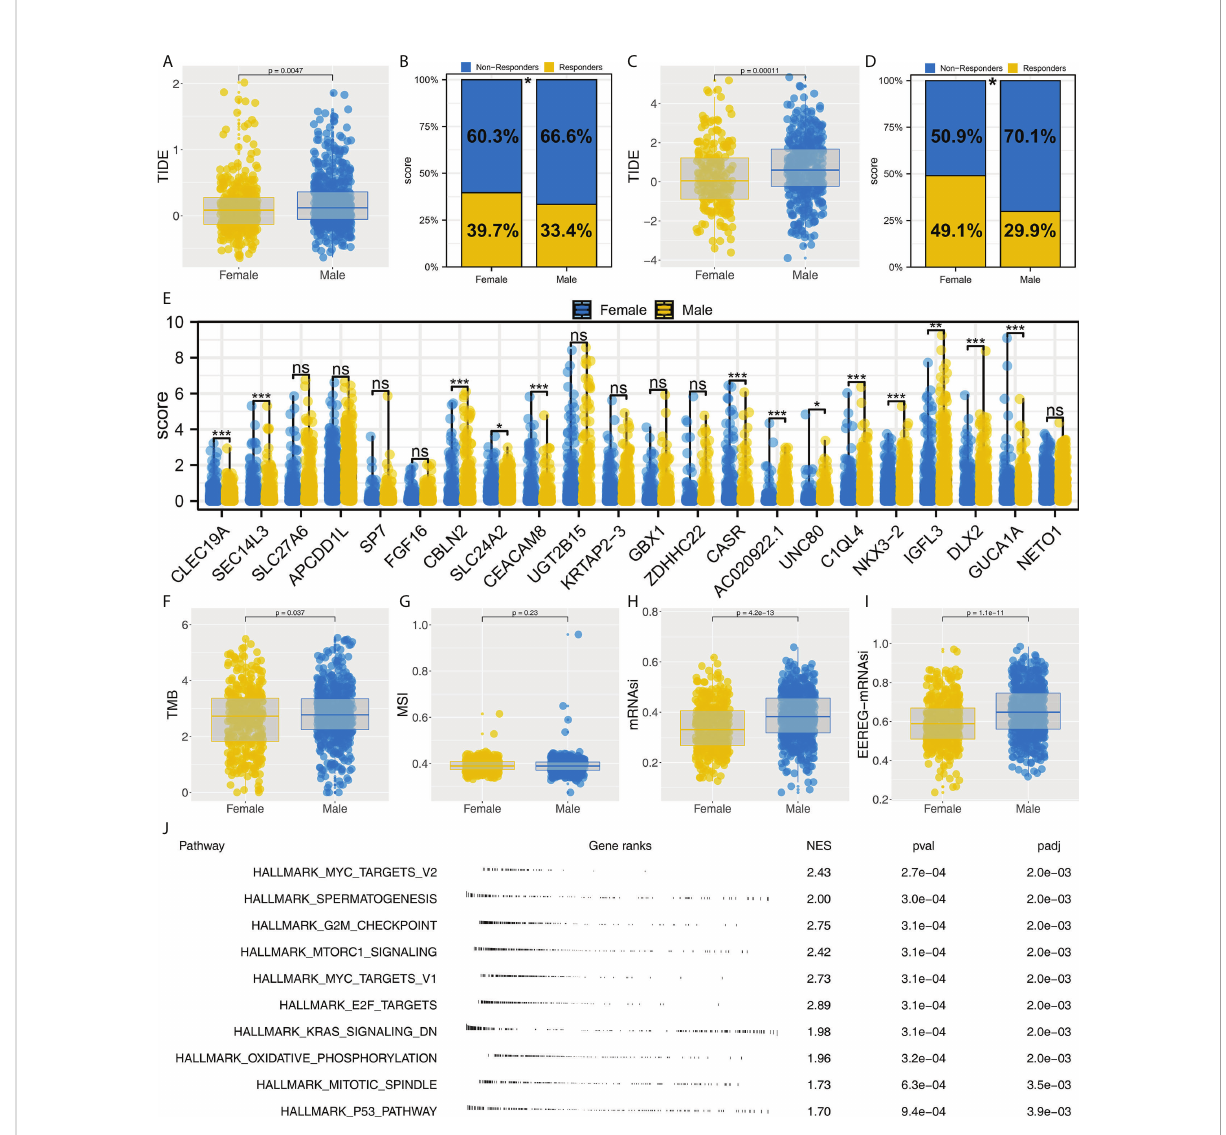
FIGURE 7 Female patients are more sensitive to immunotherapy. (A, B) Female patients had a lower TIDE score and higher proportion of immunotherapy responders in the TCGA cohort, * = P < 0.05; (C, D) Female patients had a lower TIDE score and a higher proportion of immunotherapy responders in the GEO cohort, * = P < 0.05; (E) The expression level of characteristic genes in male and female patients, ns = P > 0.05, * = P < 0.05, *** = P < 0.001,; (F – I) The difference of TMB, MSI, mRNAsi and EREG-mRNAsi in female and male patients; (J) Biological enrichment was performed to explore the underlying difference in female and male